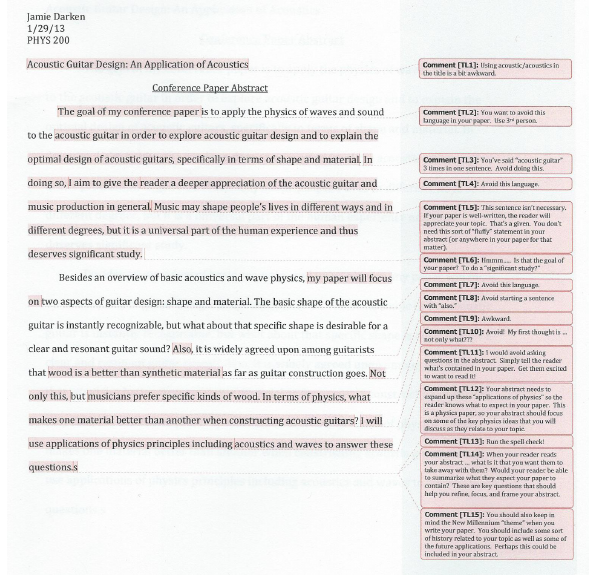
Figure 5. Abstract submission phase.